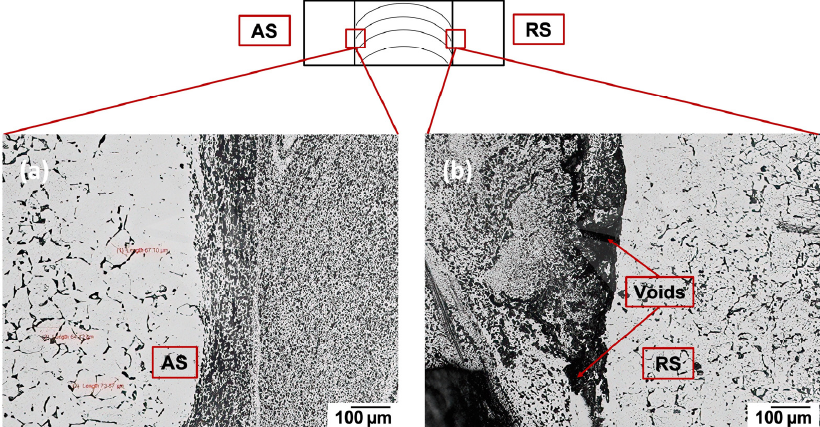
Figure 3. Optical microscopic pictures of etched 6022 Al from the top perspective: ( a ) Advancing side (AS) and ( b ) retreating side (RS).